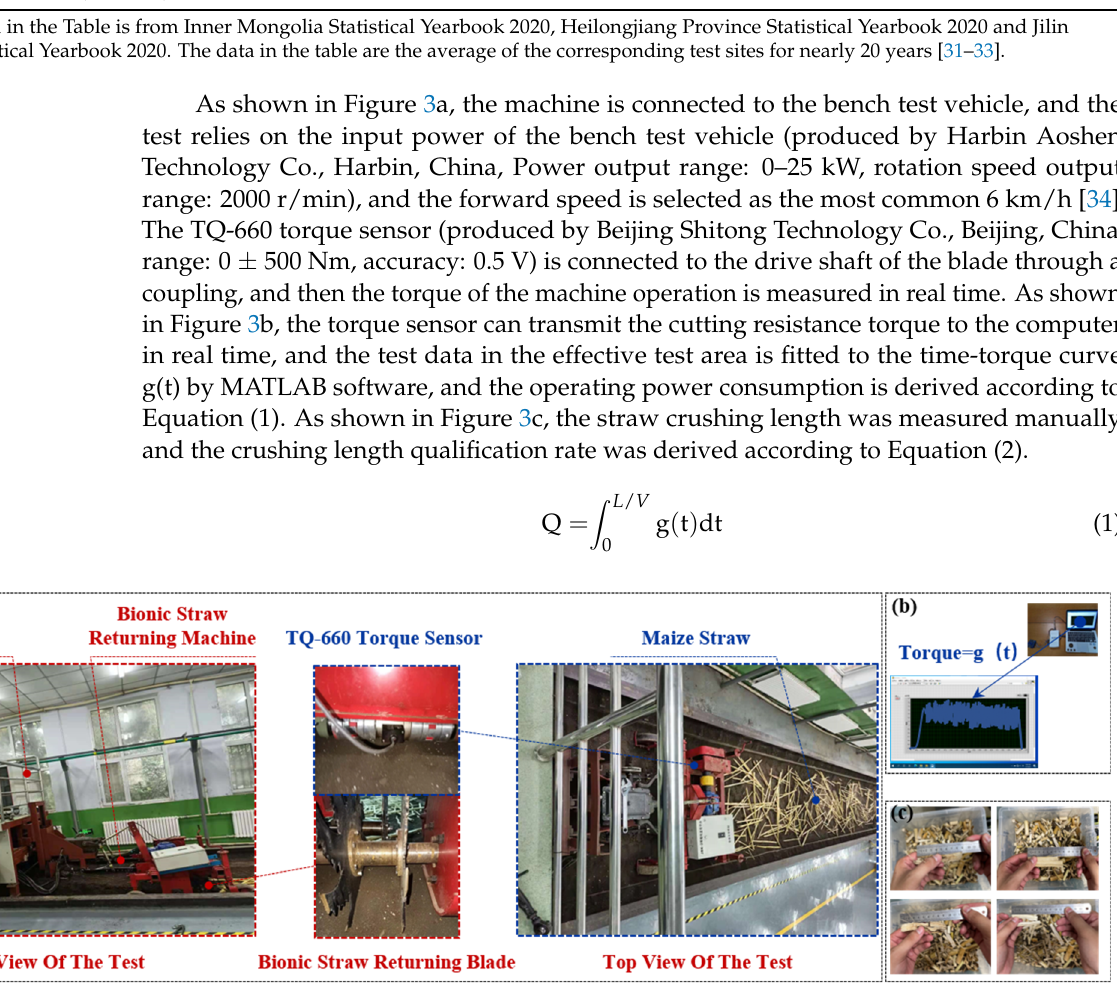
Figure 3. Soil bin test procedure. ( a ) Test equipment linking method. ( b ) Cutting energy consumption test data output. ( c ) Manual test results of crushing length qualification rate.